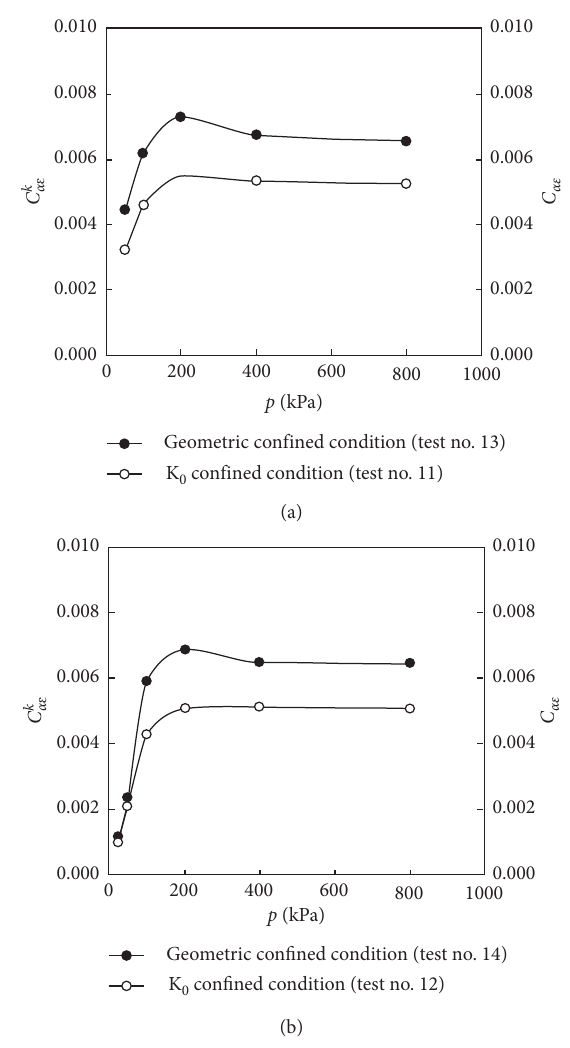
Figure 12: The comparison of the relationship between creep coefficients and the consolidation pressure under K 0 confinement with that under geometric confinement for (a) undisturbed soil and (b) remoulded